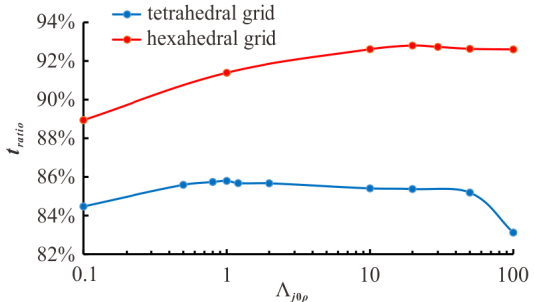
Figure 14. Slice of density (up) and magnetization (down) at x = 7500 m. ( a , f ) Real model; ( b , g ) separate result under tetrahedral grid; ( c , h ) joint result under tetrahedral grid; ( d , i ) separate result under combined hexahedral grid; ( e , j ) joint result under combined hexahedral grid.